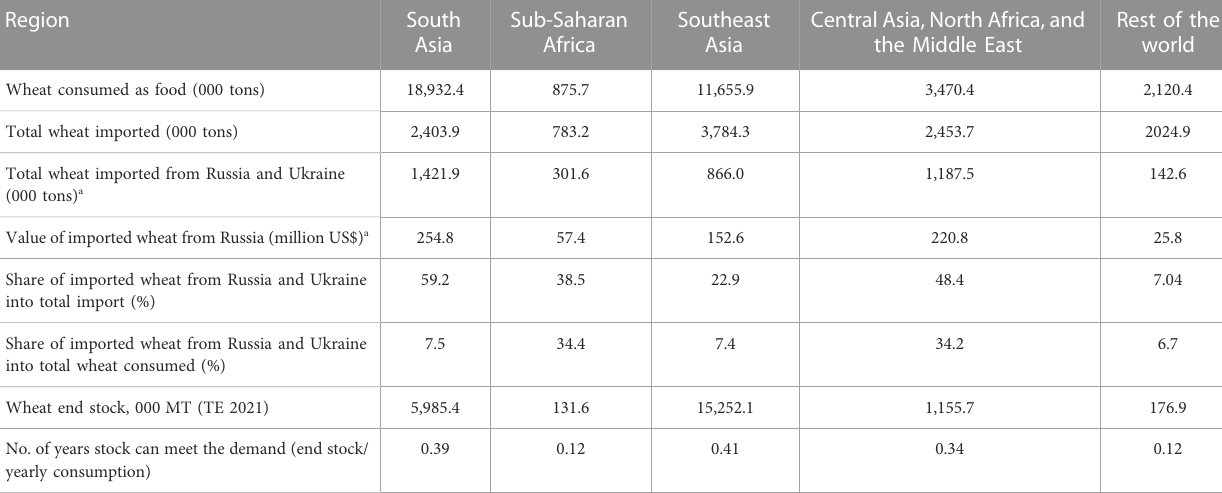
TABLE 5 Share of wheat import, and wheat import from Russia and Ukraine into total wheat consumption (000 tons) in the sampled regions.